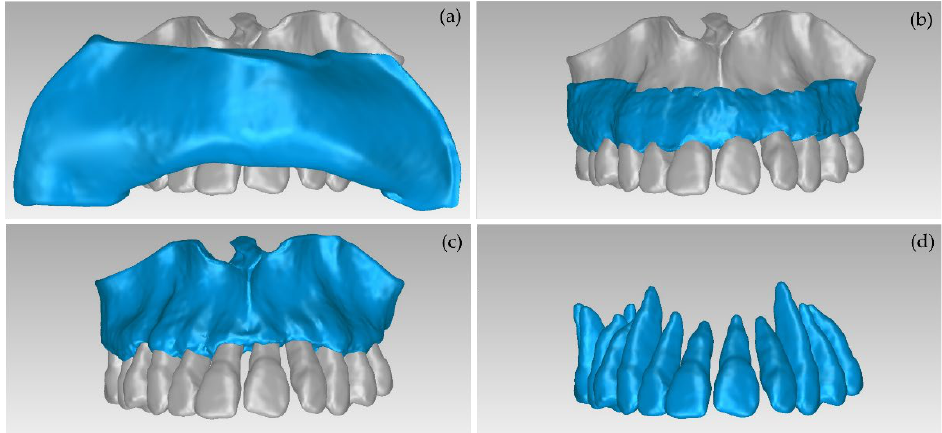
Figure 7. 3D models of teeth, alveolar bone, gums, and lips after their processing via the Geomagic Wrap software; ( a ): teeth, alveolar bone, gums, lips (shown in blue); ( b ): teeth, alveolar bone, gums (shown in blue); ( c ): teeth, alveolar bone (shown in blue); ( d ): teeth.